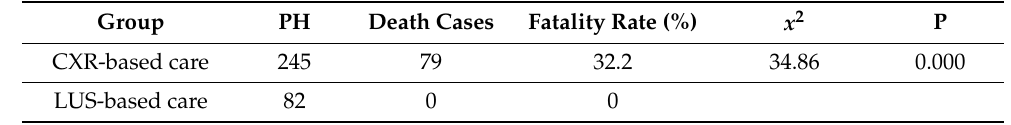
Table 3. The influence of LUS-based care on fatality rate of pulmonary hemorrhage. Group PH Death Cases Fatality Rate (%) x 2 P CXR-based care